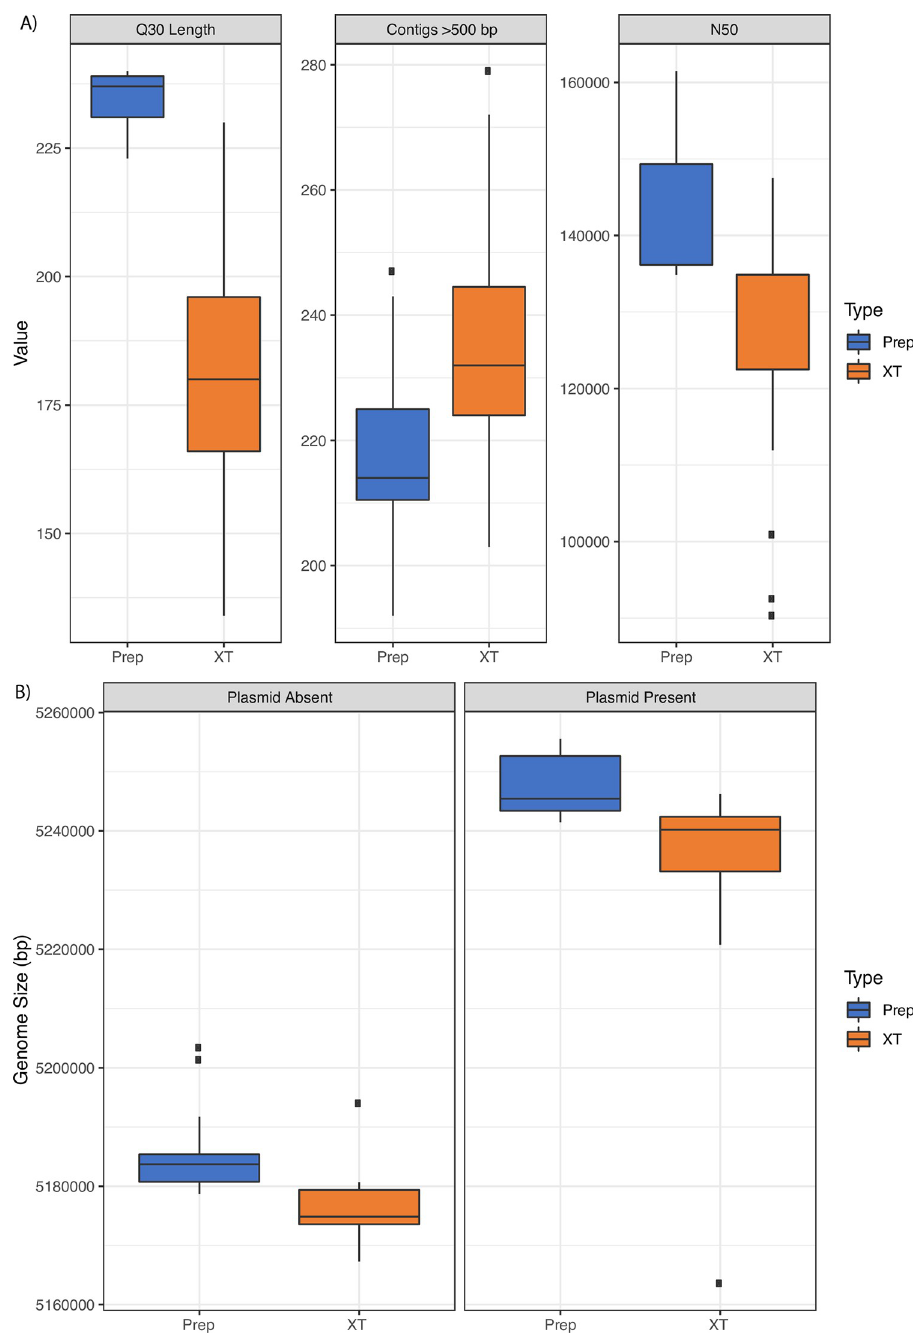
Fig 1. Comparison of the statistics for DNA library kit. The DNA Prep kit resulted in sequencing reactions that rendered the better read length quality, assemblies and N50s. A) Q30 read length, Contigs, and N50 for the data prepared with the two library preparation methods. B) The overall genome size distribution of isolates with and without the plasmid based on library